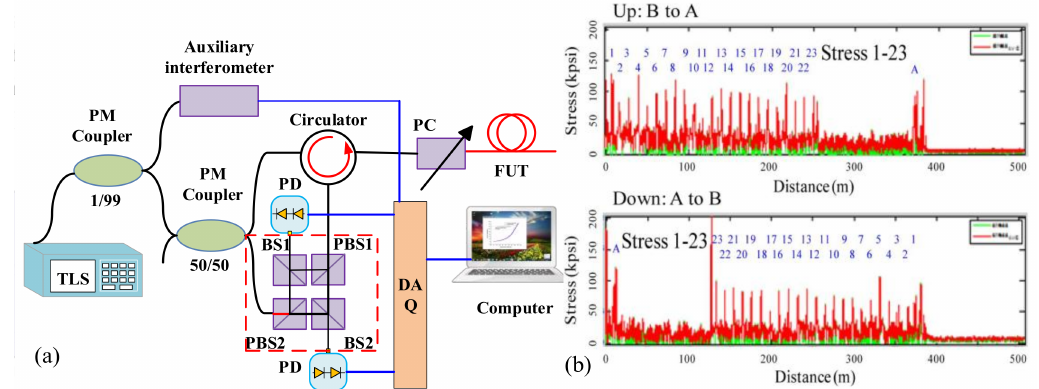
Figure 26. ( a ) Experimental setup of distributed transversal stress sensing by the local birefringence information using a P-OFDR. TLS is tunable laser source. PC is a polarization controller. PBS is polarization beam splitter. PD are photo-detectors. BS 1 and 2 are free-space polarization insensitive beam splitters. DAQ is data acquisition card. Auxiliary interferometer provides the external clock for DAQ. This figure is adapted from Wei et al. [59]. ( b ) Distributed stress measurement of a 250 m fiber coil (reprinted from Wei et al. [59] with permission of OSA; copyright